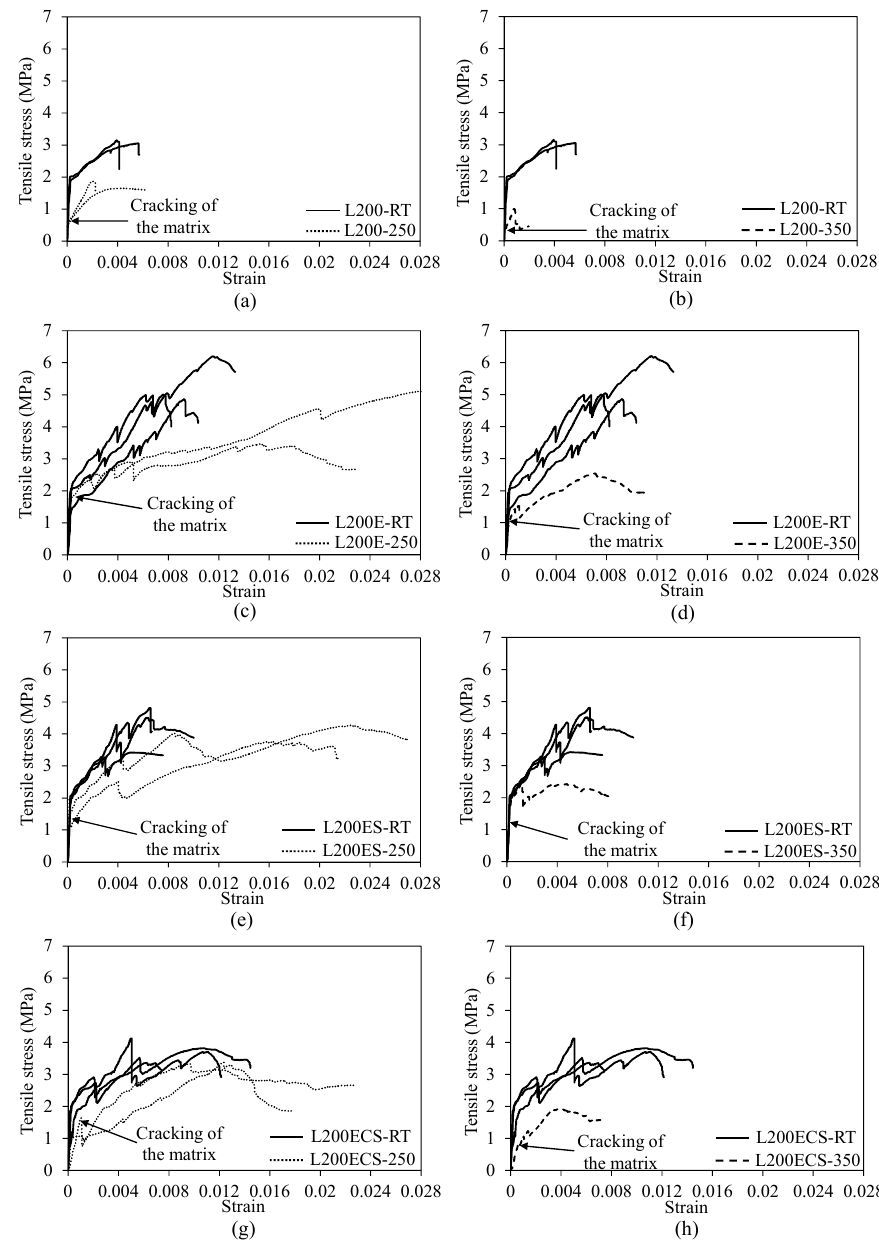
Figure 16. Stress–strain relationship of ( a ) L200 at 250 ◦ C, ( b ) L200 at 350 ◦ C, ( c ) L200E at 250 ◦ C, ( d ) L200E at 350 ◦ C, ( e ) L200ES at 250 ◦ C, ( f ) L200ES at 350 ◦ C, ( g ) L200ECS at 250 ◦ C, and ( h ) L200ECS at 350 ◦